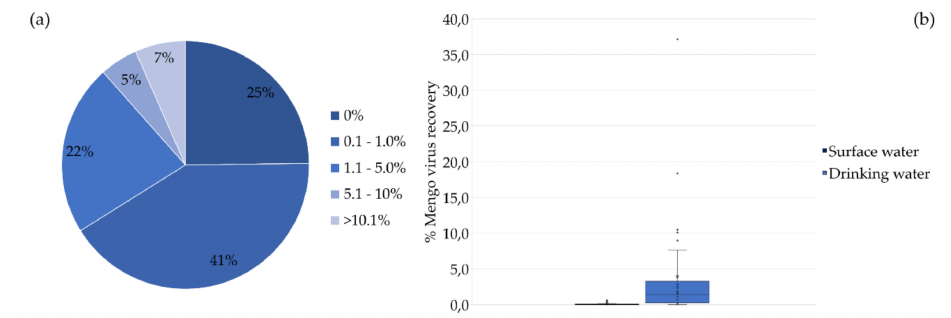
Figure 4. Recovery of the process control virus (%) in the water samples analyzed. ( a ) Mengo virus recovery in surface water and drinking water samples ( n = 59). ( b ) Box plot generated with Mengo virus recoveries in samples from surface water and drinking water samples ( n = 59); X represents the average recovery value.